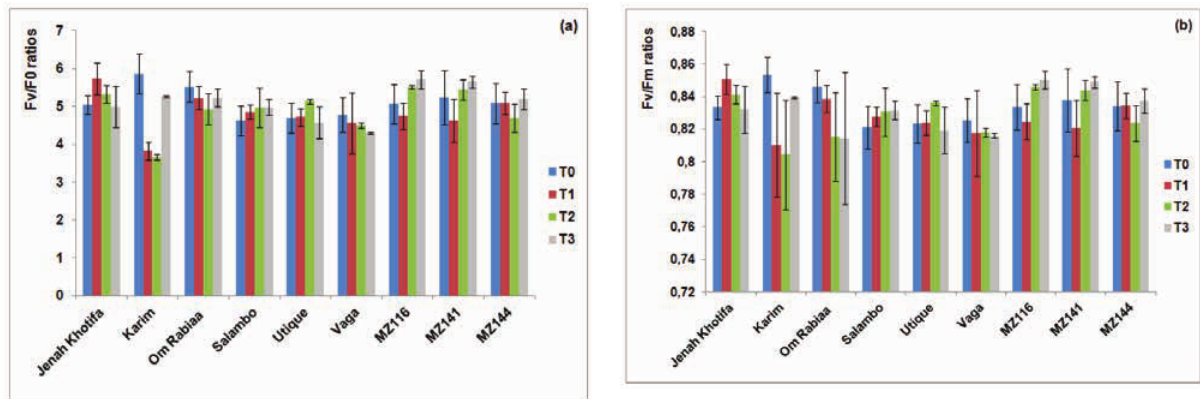
Figure 3: Variation of Fv/F0 (a) and Fv/Fm (b) parameters among the investigated durum wheat (Jenah Khotifa, Karim, Om Rabiaa) and common wheat varieties (Salambo, Utique, Vaga) and wild wheat accessions (MZ116, MZ141, MZ144) according to the four salt treatments (T0=0, T1= 50, T2=100 and T3=150 mM NaCl)